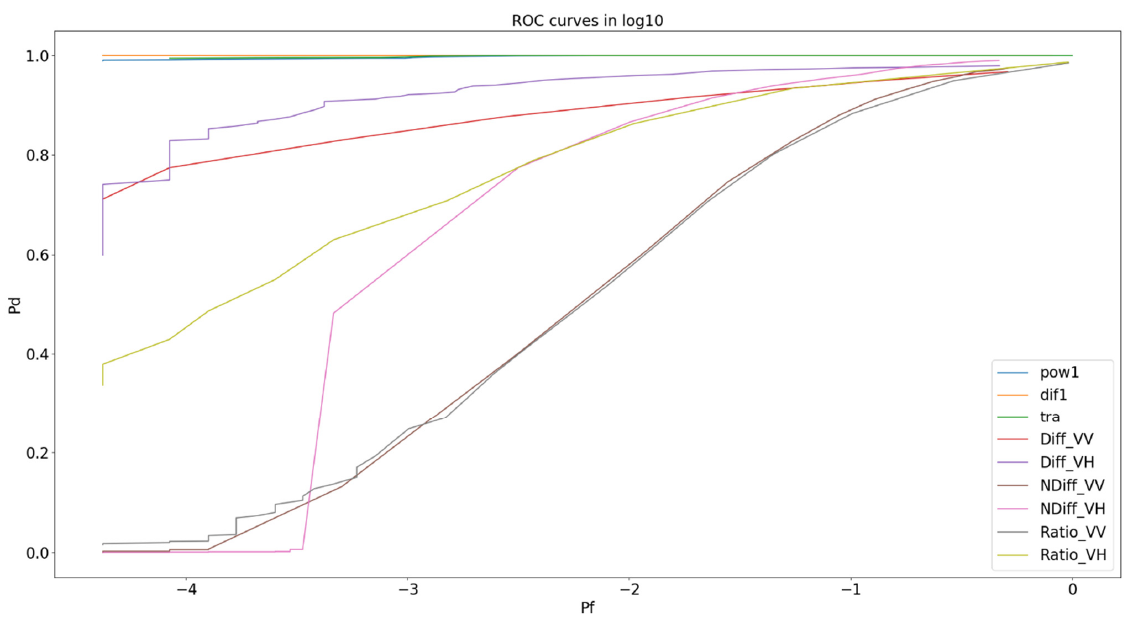
Figure 13. ROC curve in linear format showing change detectors used on 19 January 2020 paddy & 24 April 2020 data: Difference VV and VH (Diff_), Ratio VV and VH (Ratio_), Normalised Difference (NDiff_), Power Difference (Dif1), Power Ratio (Pow1) and Trace (HLT).